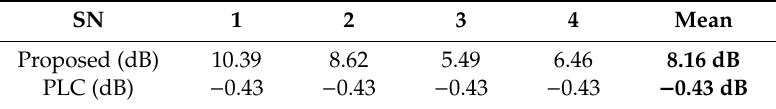
Table 4. RRSs of the false targets in green boxes.